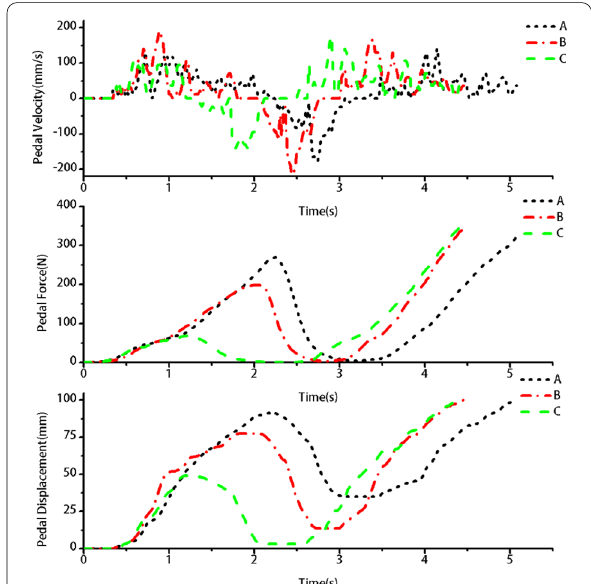
Figure 14 Variations in the pedal parameters during the intermittent braking